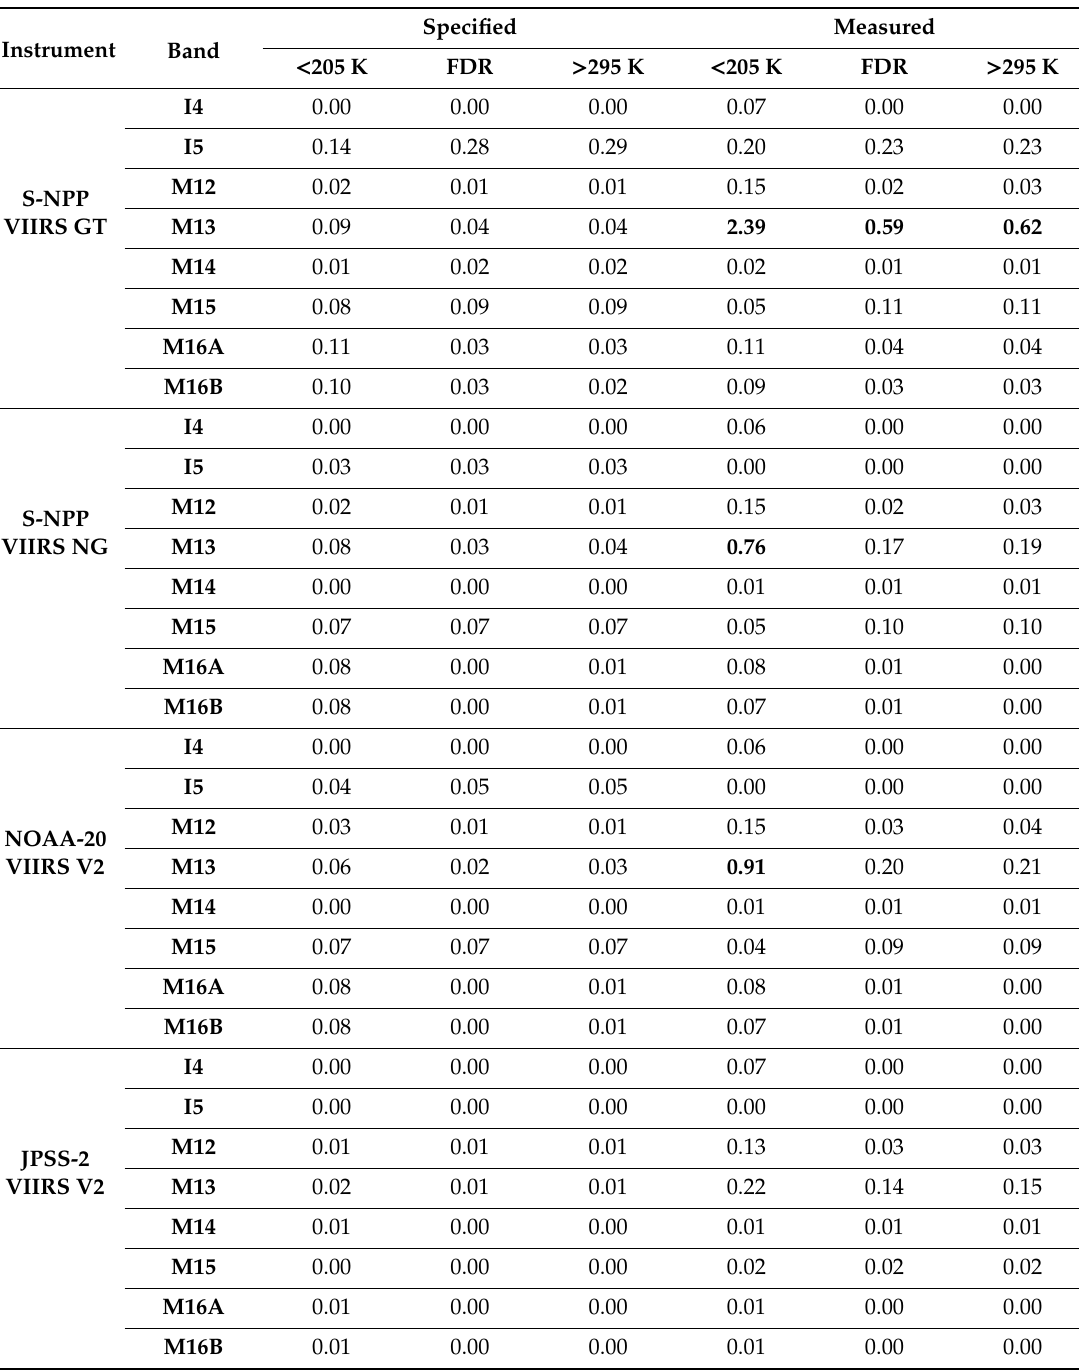
band M13 RSR, and how the impact of in-band vs. OOB magnitude can change depending on scene temperature. Figure 7a allows for close analysis of the in-band measurement range, whereas Figure 7b uses alternative axes scaling limits in order to grant full view of the band M13 OOB measurement range. Table 11. VIIRS RSR Earth-emitted (and Earth-reflected for daytime I4, M12, and M13 bands) temperature-dependent radiance average OOB contribution ( γ ) for specified and measured 1% extended bandpass limits, shown in %, analyzed separately where Aqua MODIS 11- µ m band-integrated IASI infrared brightness temperature (IR BT) is less than 205 K, is greater than 295 K, and with no BT limit specified (i.e., full dynamic range or